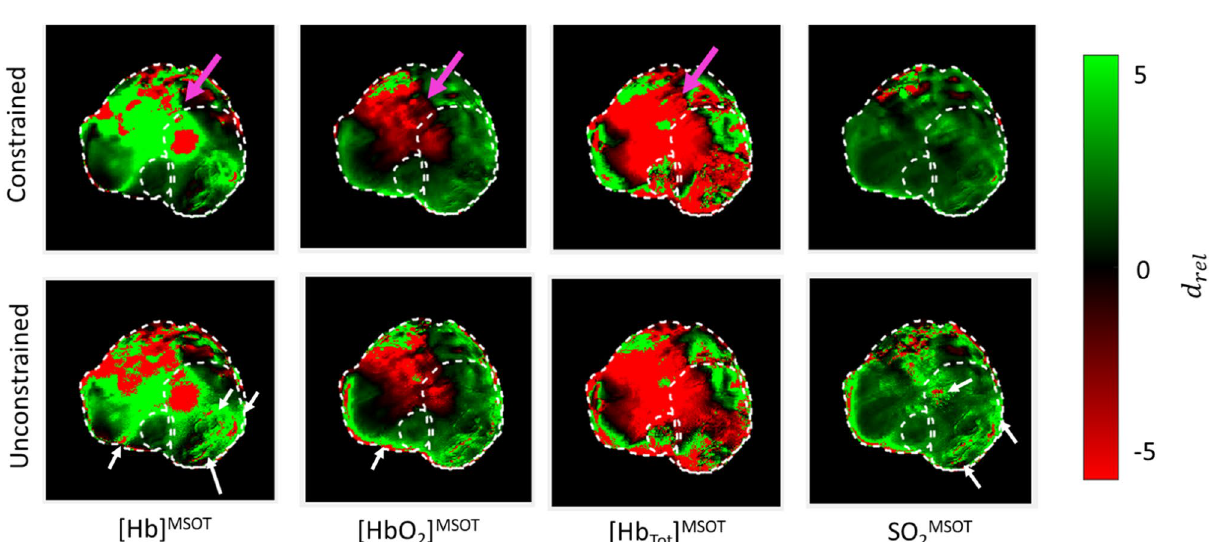
Figure 10. Relative Cohen’s d (Supplementary Information) of drug administration calibrated against oxygen- air transition during initial gas challenge in Dataset A. In both constrained and unconstrained [Hb] MSOT and [HbO 2 ] MSOT images, there is a large region of anomalous relative effect (magenta arrows), likely due to changes in measured [Hb tot ] MSOT over the course of the experiment. This large region is absent in the SO 2MSOT analyses due to the ratiometric calculation. More localized artifacts such as those highlighted in the unconstrained analysis (white arrows) are due to modelling or reconstruction inaccuracies, and so are not compensated by calculating SO 2MSOT . Figure created using a combination of MATLAB and Microsoft